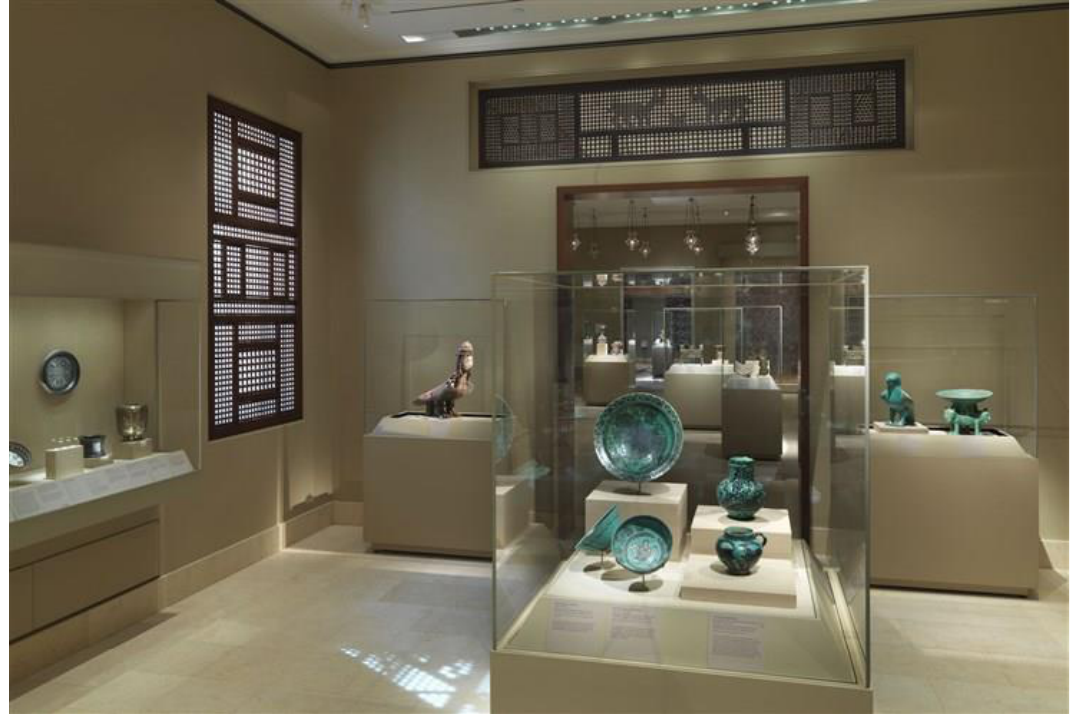
Figure 17. View of the gallery of “ The Art of the Arab Lands, Turkey, Iran, Central Asia and Later South Asia”, Metropolitan Museum of Art, New York. Photo in pub lic domain.